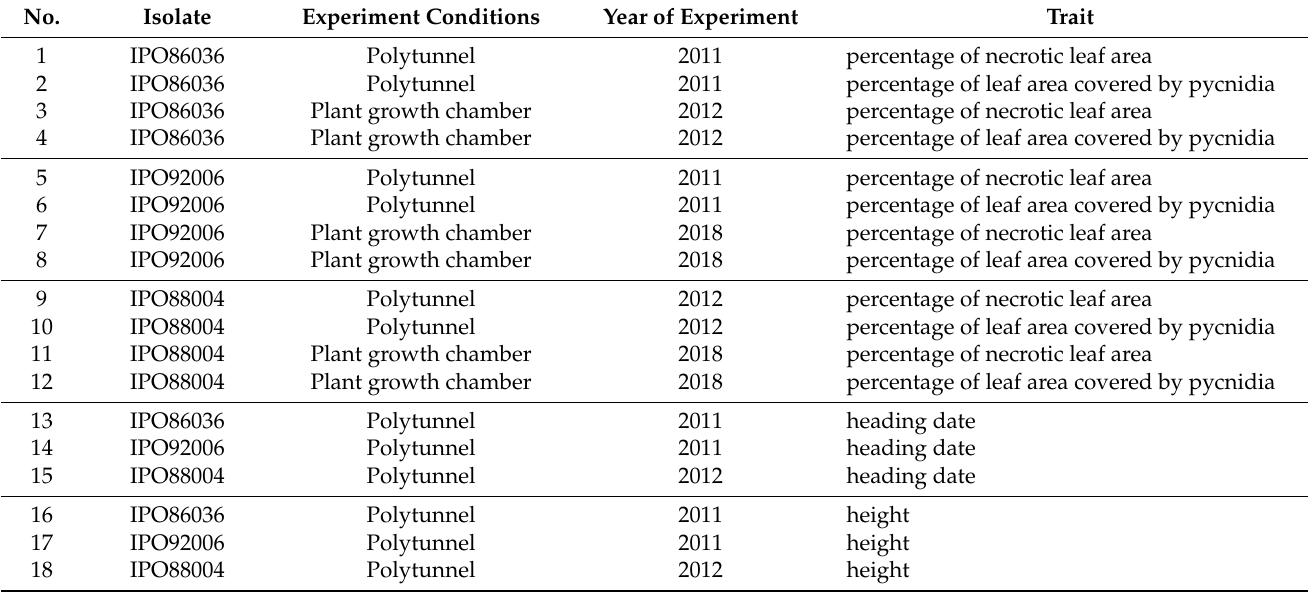
Table 1. Evaluation of Mandub × Begra mapping population for resistance to Septoria tritici blotch. No.